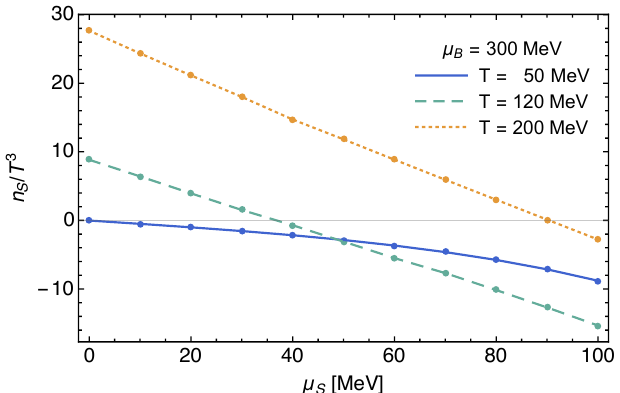
= 300 MeV for various B